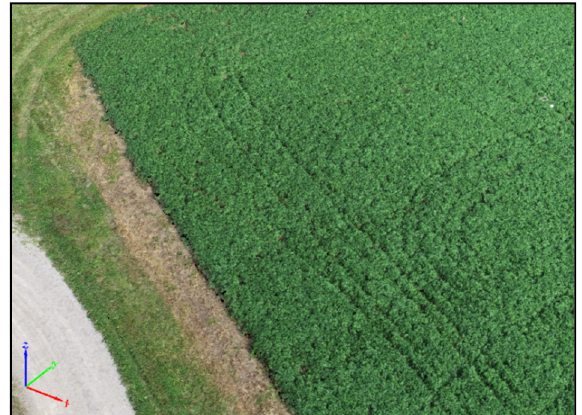
Figure 6. An aerial view of the alfalfa canopy in field 1 and tracks from wheeled traffic on a portion of a fully processed model flown on 4 June 2019 using 30–90° flight parameters.